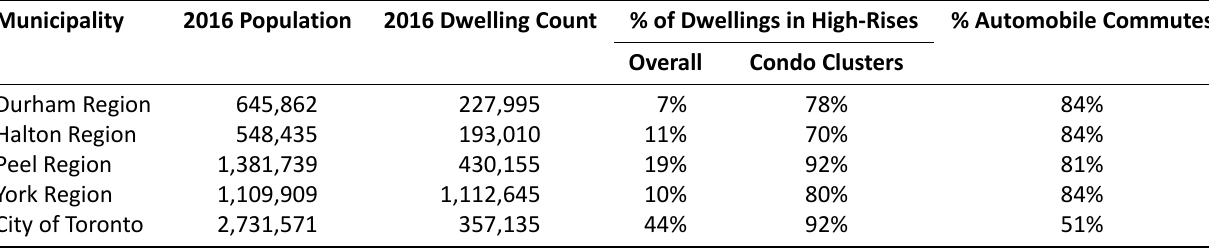
Table 1. Characteristics of the Five Municipalities in the Toronto CMA. Source: authors’ calculations using 2016 Statistics Canada census